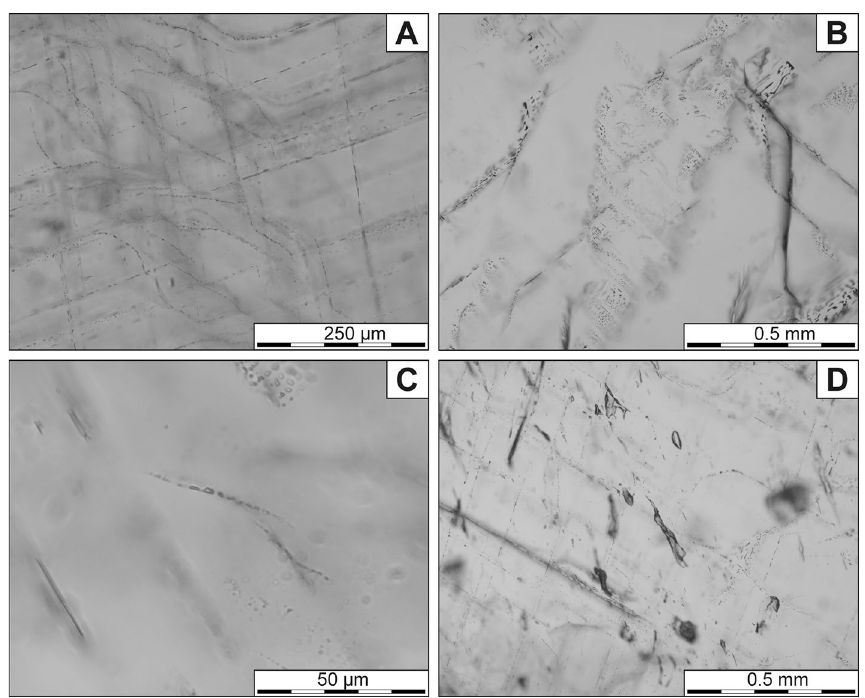
Figure 5. Fluid inclusions assemblages in barite crystals: ( A ) Areas with the blurred course of the third type of FIAs. ( B ) The fourth type of FIAs with pseudosecondary inclusions. ( C ) S-shaped FIAs of the fifth type with pseudosecondary inclusions. ( D ) Large, secondary inclusions of the sixth FIA